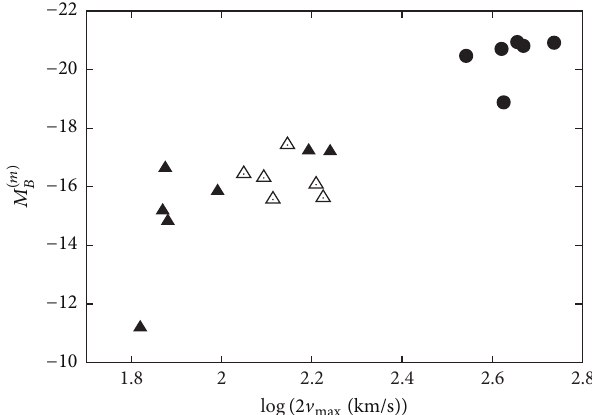
Figure 7: The baryonic Tully-Fisher relation of our galaxy sample. Absolute 𝐵 magnitudes are presented as function of the logarithm of the maximal rotational velocity. The HSB, LSB, and dwarf galaxies are represented by filled circles, empty triangles, and filled triangles,